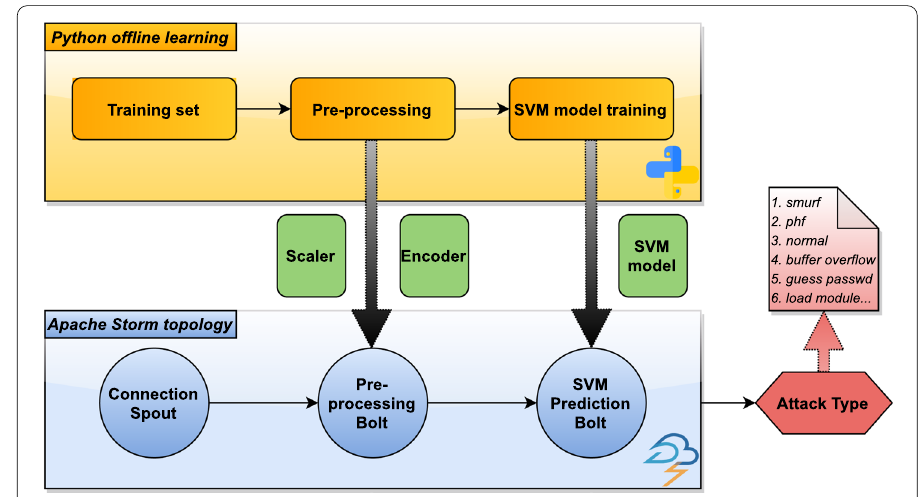
Fig. 5 Architecture of the proposed Storm